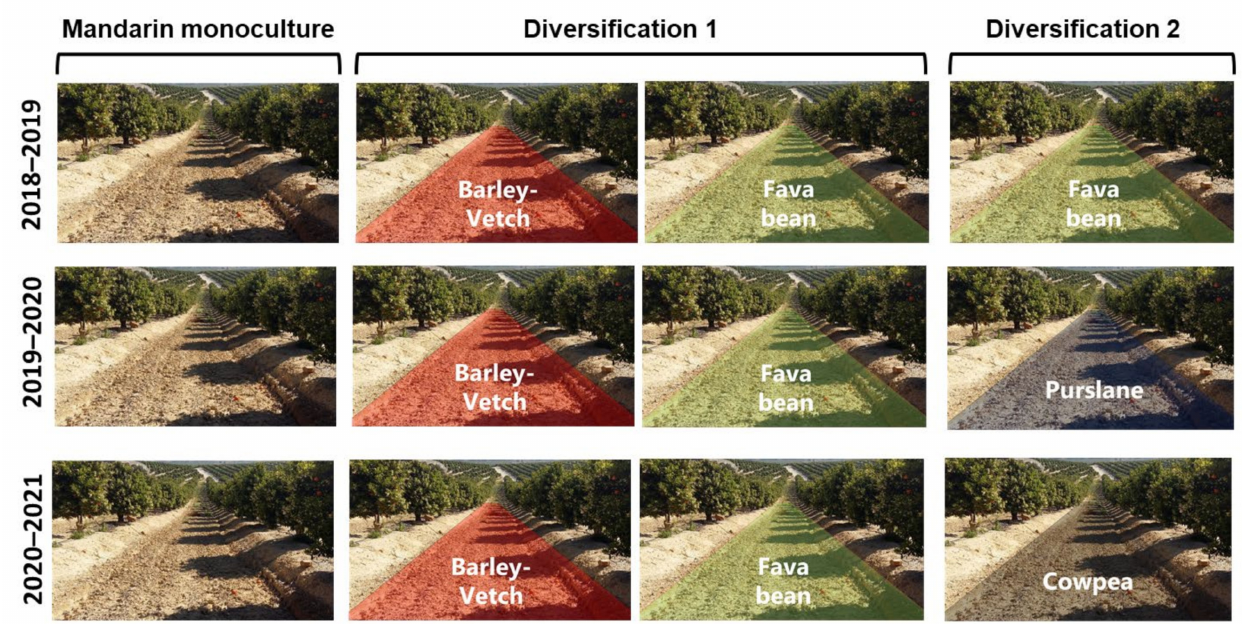
Figure 1. Schematic representation of the three intercropping practices: Mandarin monoculture (CTL), Diversification 1 (D1), and Diversification 2